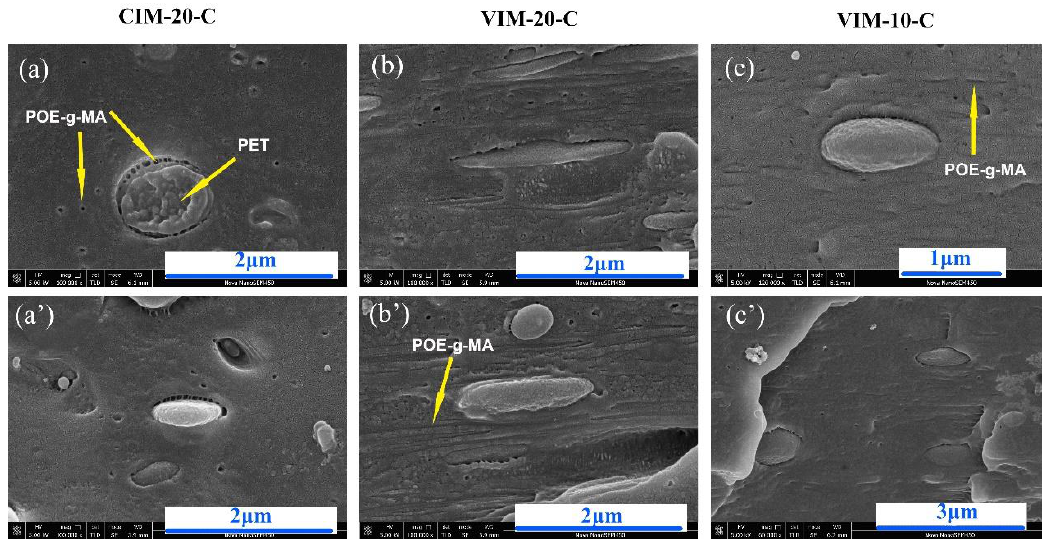
Figure 8. Core-shell structures. Arrows indicate the POE – g – MA removed by n-heptane. Flow direction is horizontal.